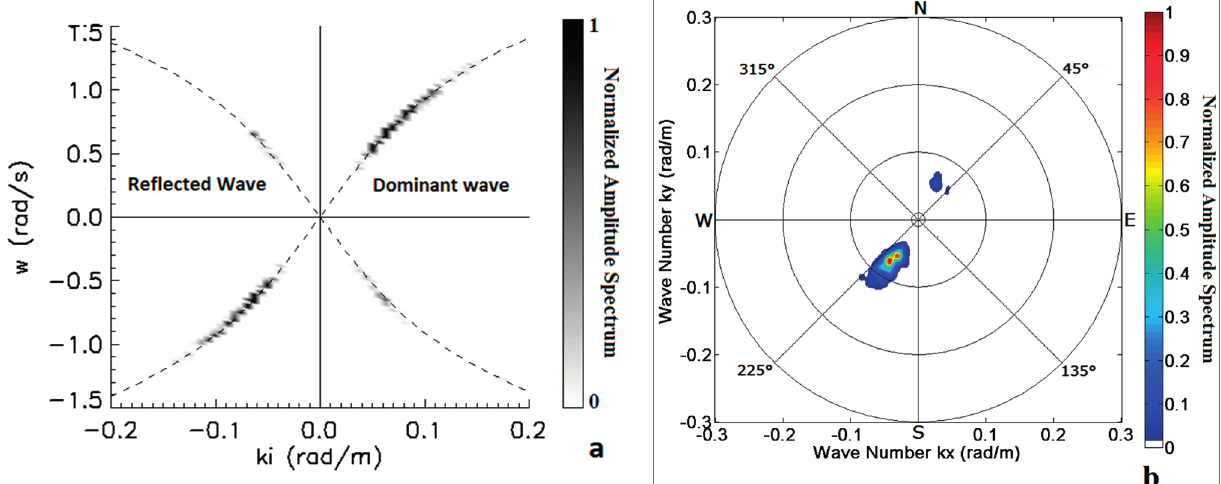
Figure 13. (Panel a ) 2D section of the 3D wave spectrum relative to the subarea A. The dashed branches are representative of dispersion relation for the incident and reflected waves; (Panel b ) 2D directional wave spectrum relative to the subarea